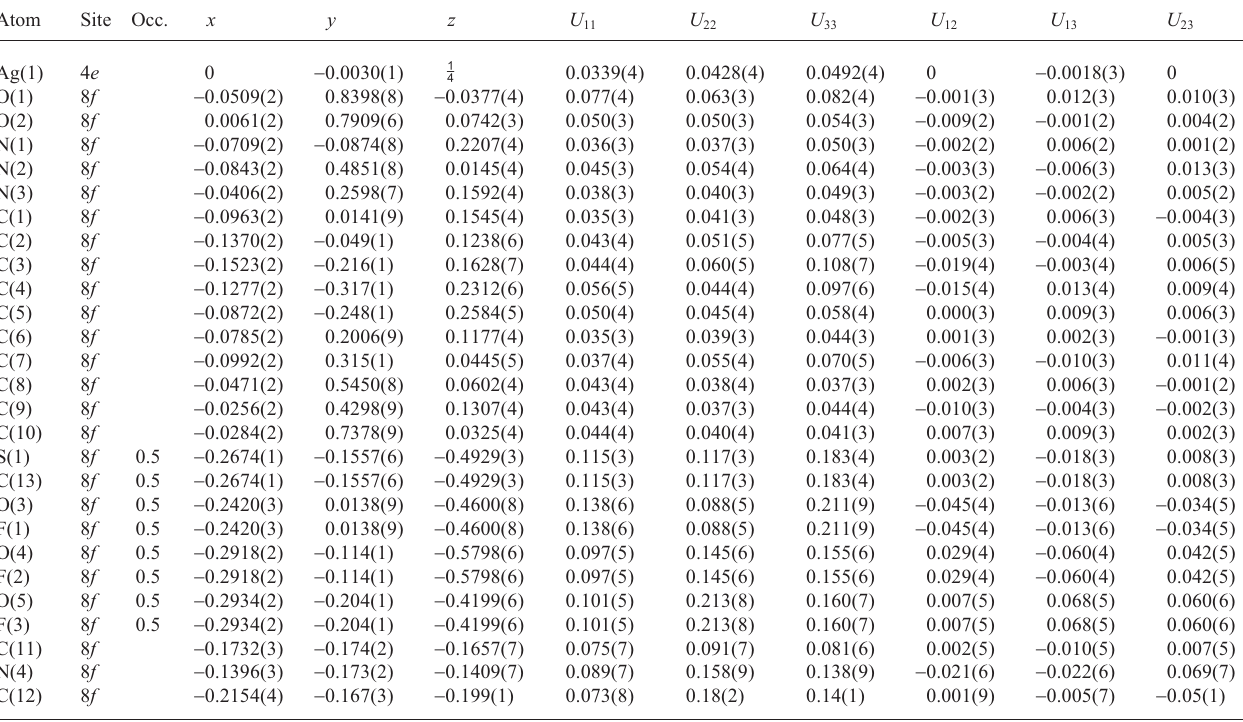
Table 3. Atomic coordinates and displacement parameters (in Å 2 ) . Atom Site